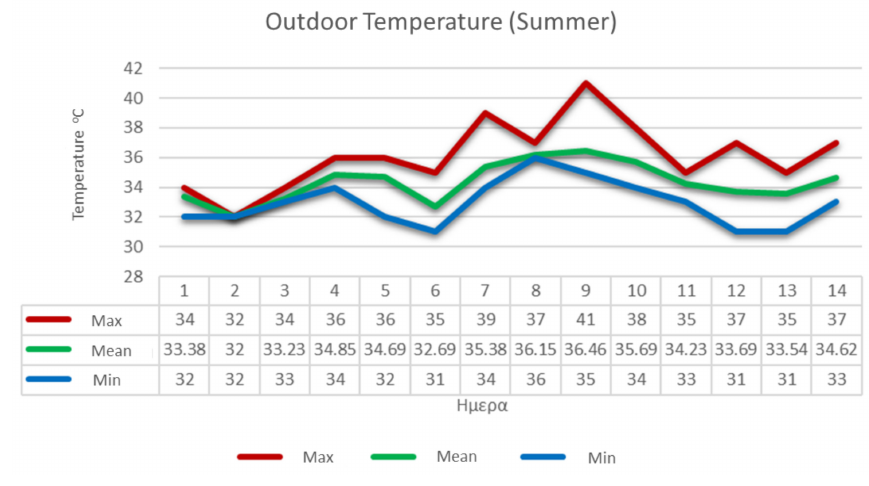
Figure 8. Outdoor humidity (summer).